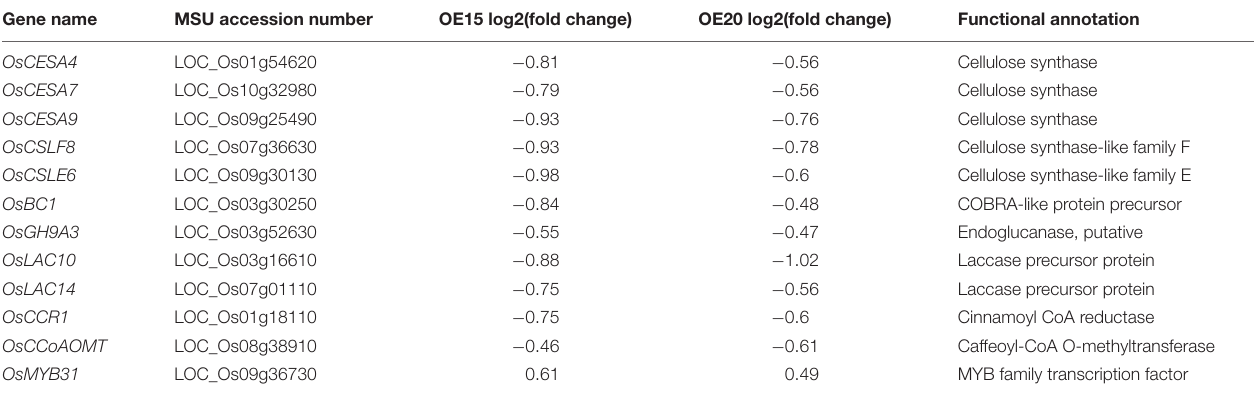
TABLE 1 | Differentially expressed genes involved in secondary cell wall biosynthesis in OsMYB305 -OE lines (OE15,